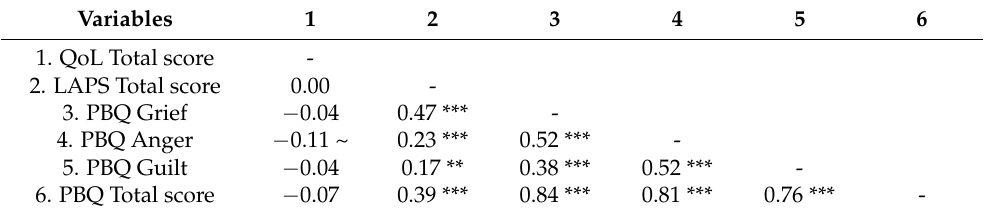
Table 2. Correlations between the study variables (N = 295).